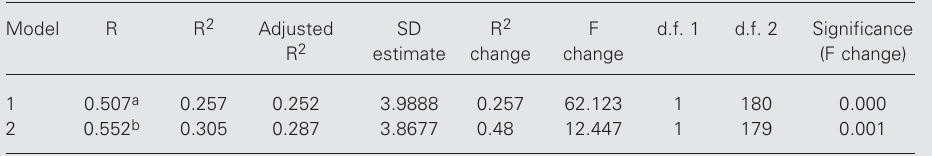
Table 7. Summary of multiple regression analysis of the model. Model